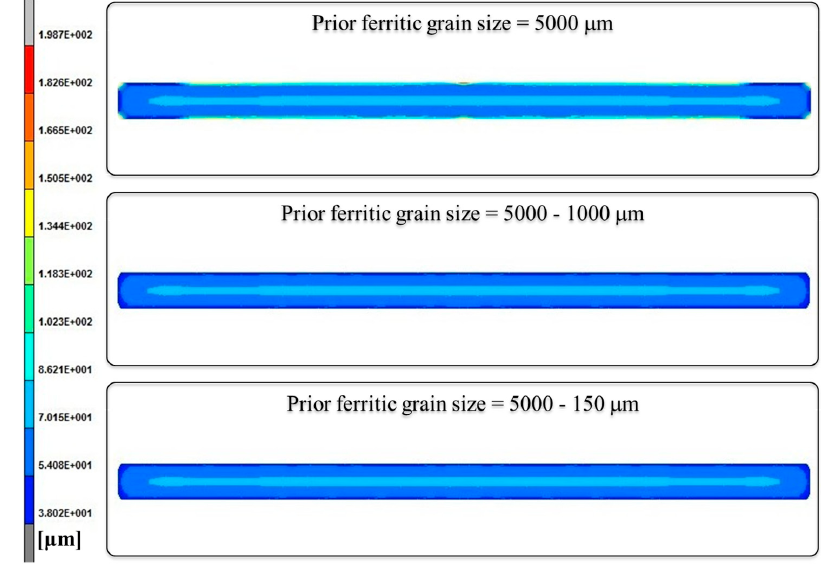
Figure 12. E ff ect of di ff erent PFGS on the ferrite grain size after the fifth roughing